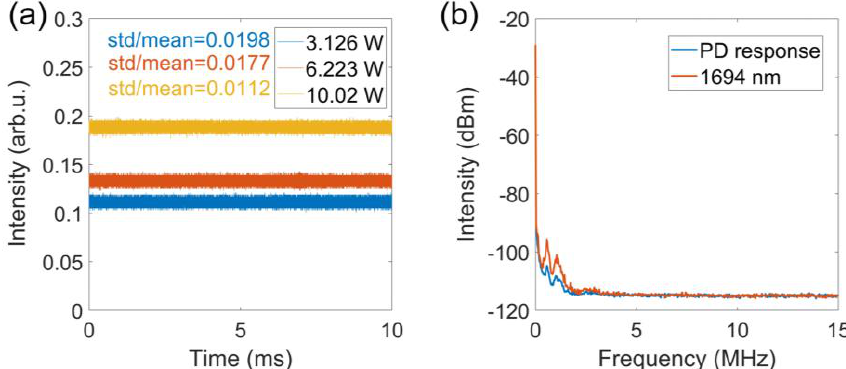
Figure 6. ( a ) Traces in the short-time temporal domain for different output powers; ( b ) radio frequency spectrum.